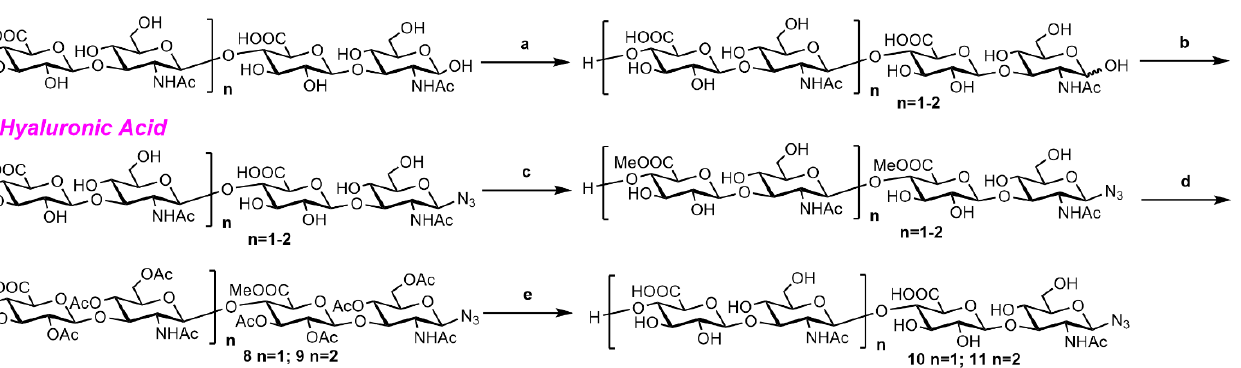
Figure 3. The synthesis of o-HA 4 N 3 ( 11 ) and o-HA 6 N 3 ( 12 ). Reagents and conditions: ( a ) 2.5% bovine testis hyaluronidase, NaOAc/NaCl buffer, pH 5.0, 37 °C, 7 days; ( b ) DMC, N-methylmorpholine, NaN 3 , H 2 O, 0 °C to rt; ( c ) 0.06 M HCl, MeOH, 4 °C, 4 d; ( d ) Ac 2 O, Et 3 N, DMAP, DCM, 2 h, 42% for 8 , 34% for 9 ; ( e ) LiOH/H 2 O 2 , THF/H 2 O, − 5 °C to rt, then 4 M NaOH, MeOH, 0 °C to rt, 85% for 10 , 86% for 11 .